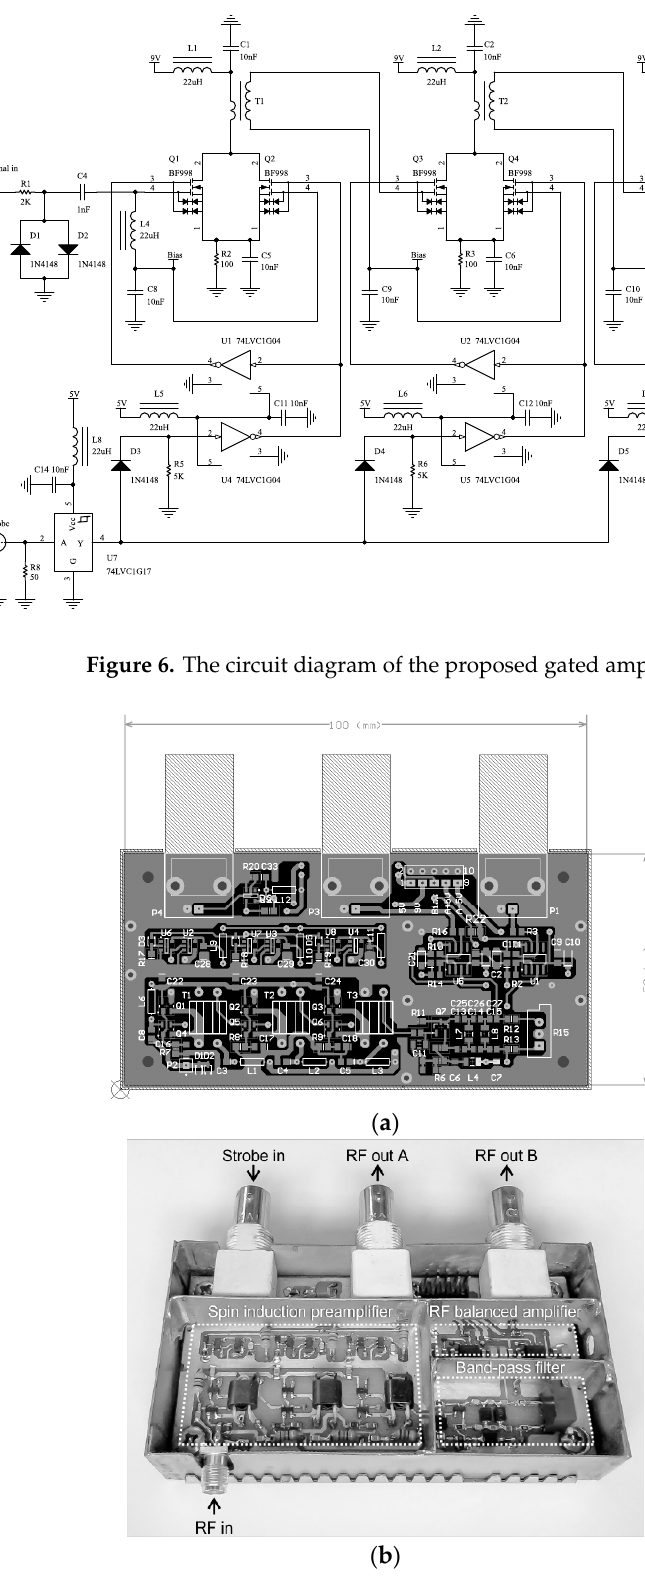
Figure 7. The design of the analog signal chain based on the gated amplifier: ( a ) printed circuit board; ( b ) Device photo.